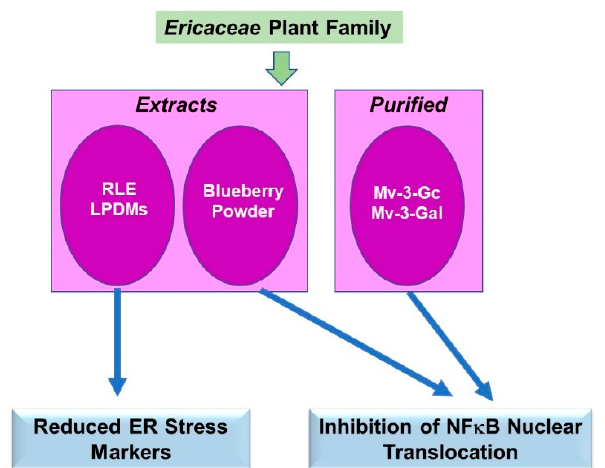
Figure 7. A schematic summary of the effects of metabolites from Ericaceae on protein trafficking dynamics.